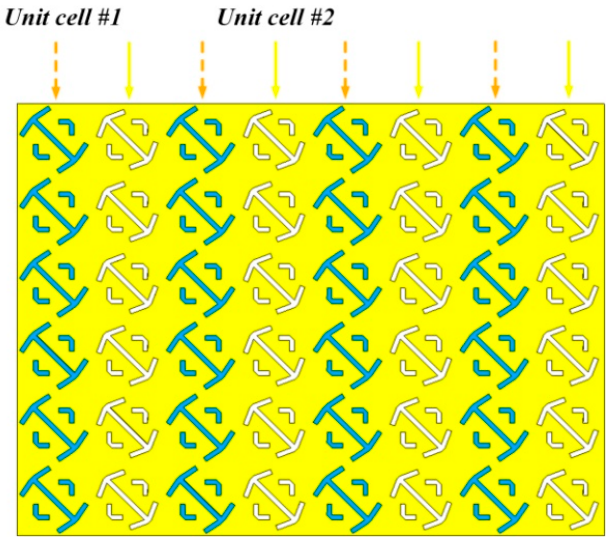
Figure 3. Comparison between the eigenmode solver simulation result of the metallic RC and RC with one metasurface wall (#1 case and #2 case).